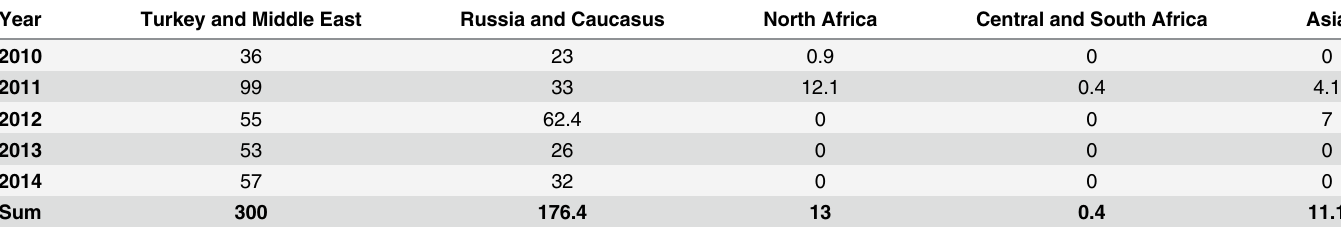
Table 2. Other POAO (in kg) seized at IA 1 according to region of origin between 2010 –